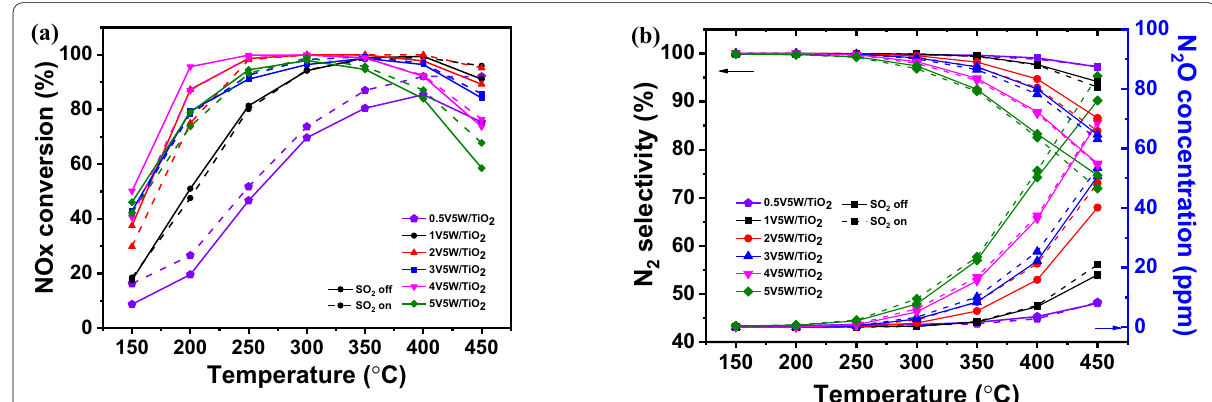
Fig. 5 NOx removal efficiencies of the synthesized SCR catalysts according to vanadium content measured in the temperature range 150–450 °C a NOx conversion and b N 2 selectivity and N 2 O concentration. Reaction conditions: [NOx] [O 2 ] 5%, balance N 2 , total flow 500 sccm, and the gas hourly space velocity (GHSV) =